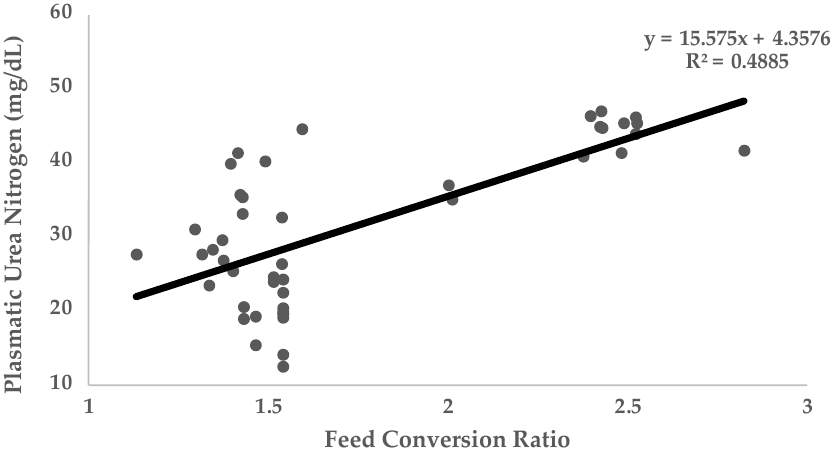
Figure 3. Relationship of plasmatic urea nitrogen (PUN) with feed conversion ratio. Data obtained from four published studies in growing pigs [65,66,73,75,76,78].